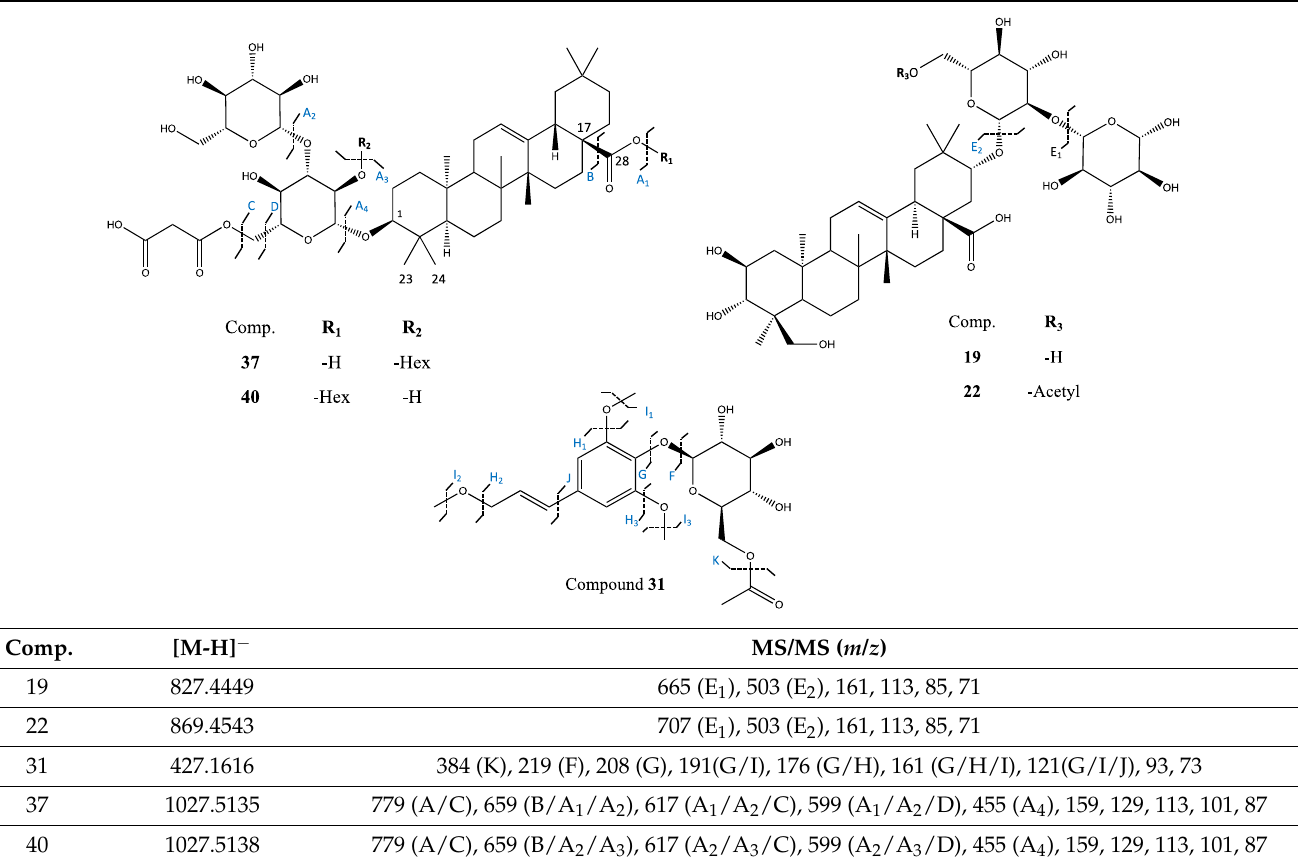
Table 3. Chemical structure and fragmentation pattern of compound 19 and potential new com- pounds 22 , 31 , 37 , 40 identified by ESI-HRMS and MS/MS analysis.